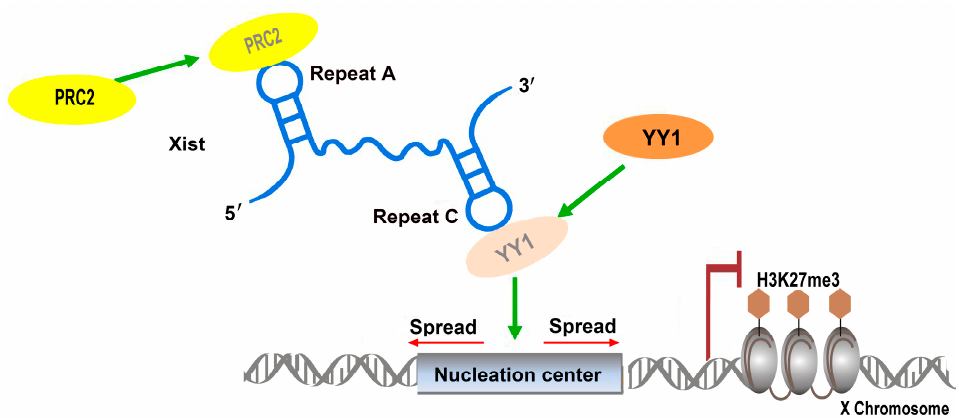
Figure 2. Xist repetitive element functions during X-chromosome inactivation. A-repeat, which contains two long stem-loop structures, is involved in PRC2 binding, while C-repeat binds YY1, assisting Xist-PRC2 complex in targeting the specific sites on Xi, and inducing histone H3 lysine K27 trimethylation (H3K27me3) and X-linked gene silencing.